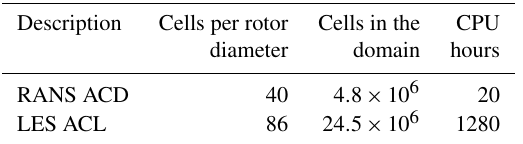
Table 6. Averaged computational effort in CPU hours to perform the simulations of case